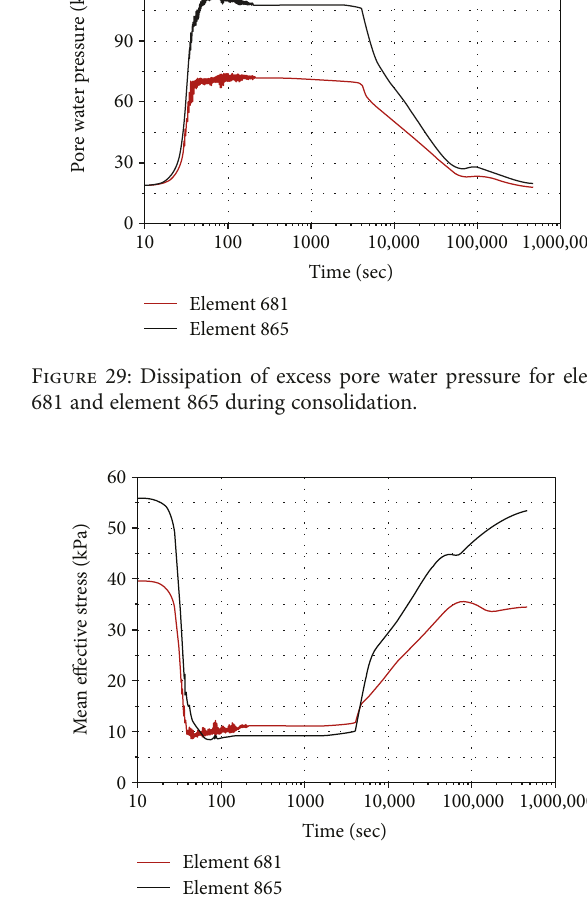
Figure 30: Recovery of mean e ff ective stress for element 681 and element 865 during